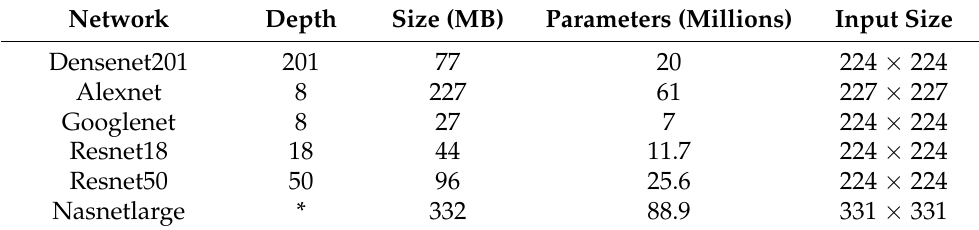
Table 1. Description of adopted pretrained network. Only about Nasnetlarge no depth information is